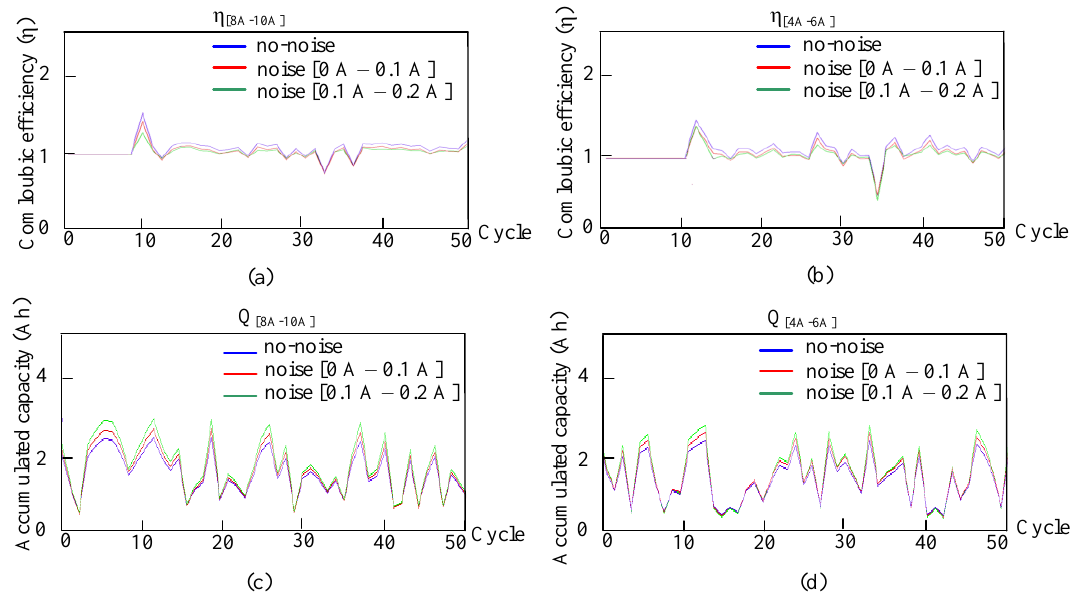
Figure 14. The relative errors in different noisy environments. ( a ) η [8A-10A] ; ( b ) η [4A-6A] ; ( c ) Q [8A-10A] ; ( d ) Q [4A-6A]